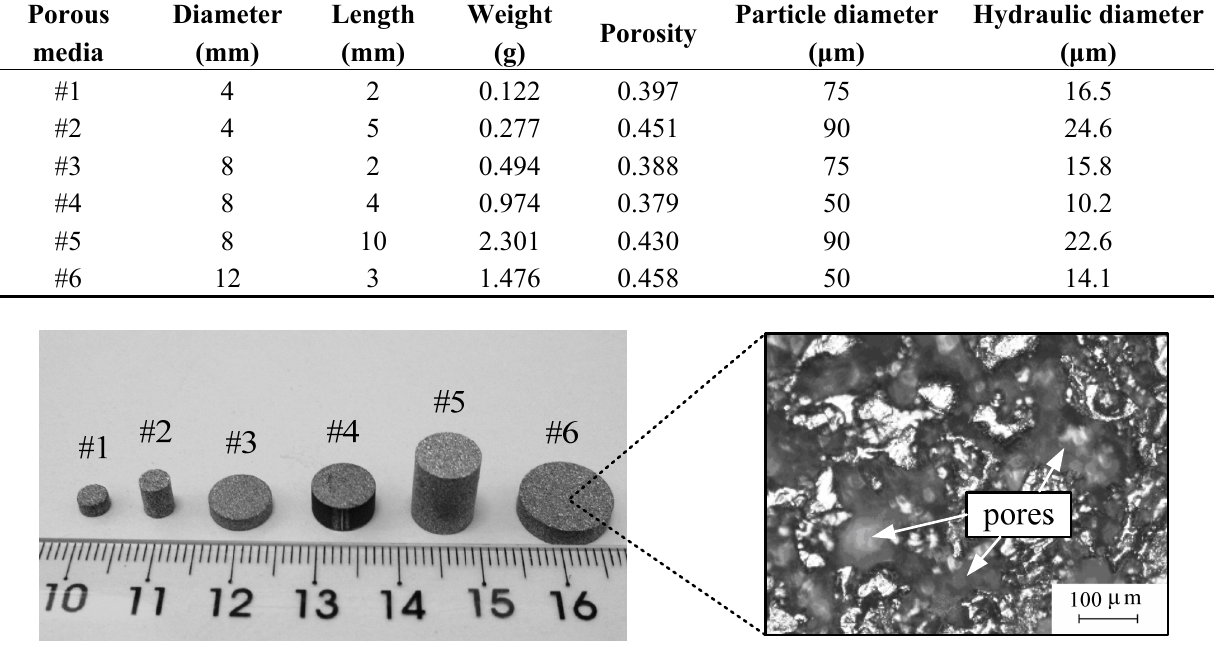
Figure 2. Test porous